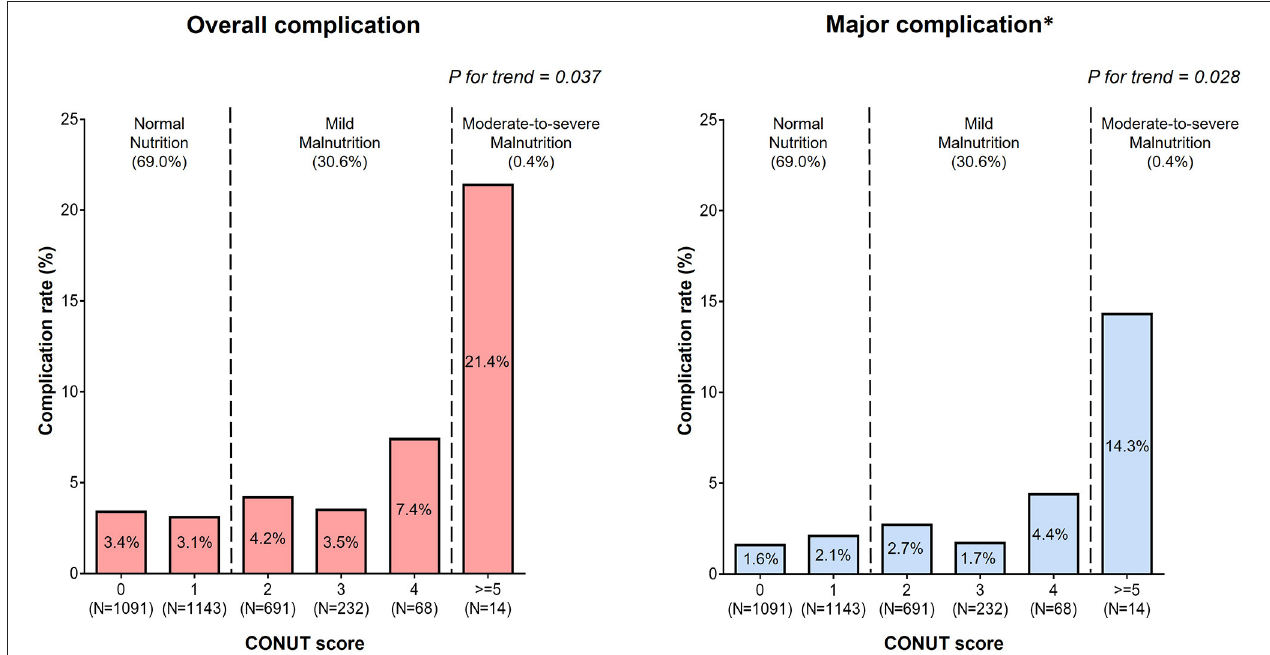
Normal nutrition: CONUT 0-1 ( n =